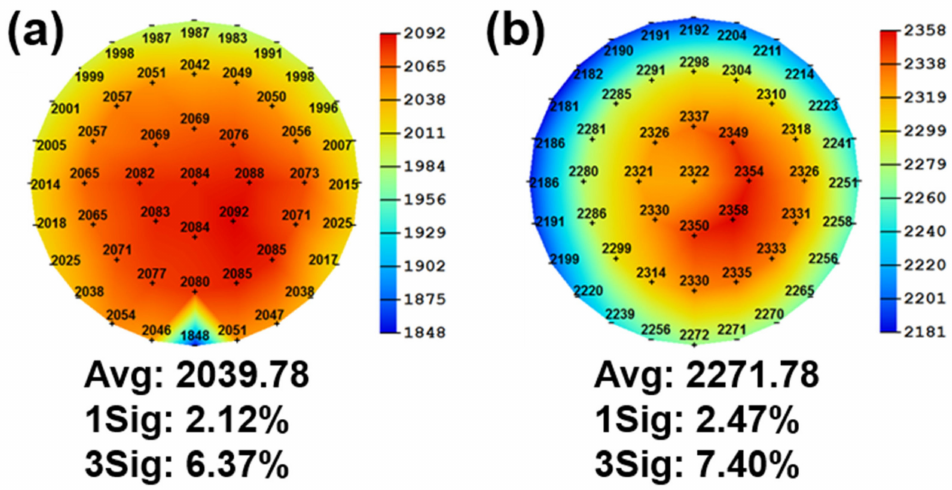
Figure 5. Dry etch rate map of the film using ( a ) C 3 H 6 and ( b ) C 2 H 2 at 400 ◦